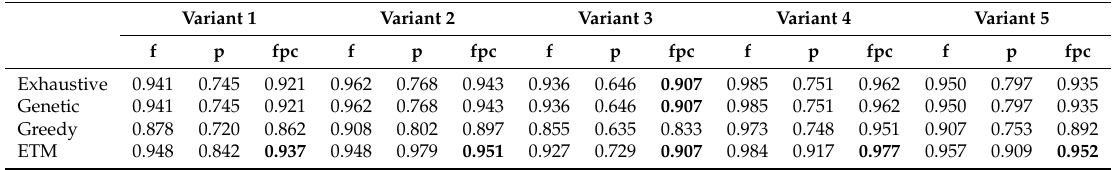
Table 3. Results for CPT 3-B and the event logs corresponding to the five process variants. Variant 1